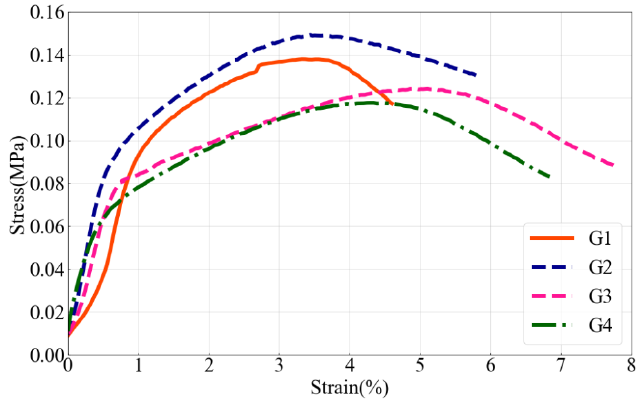
Figure 10. Stress–strain curves of similar